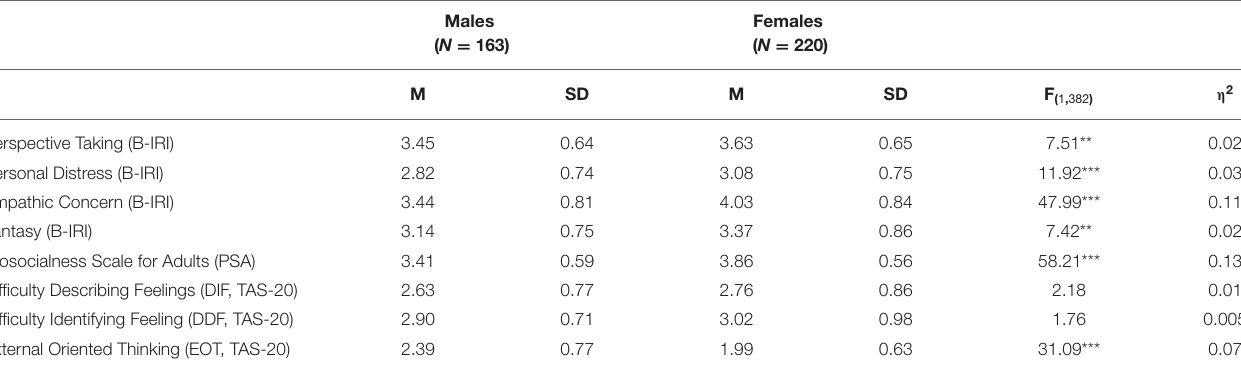
TABLE 7 | Means and standard deviations of the Brief IRI , PSA , TAS-20 by Gender, F and η 2 values.